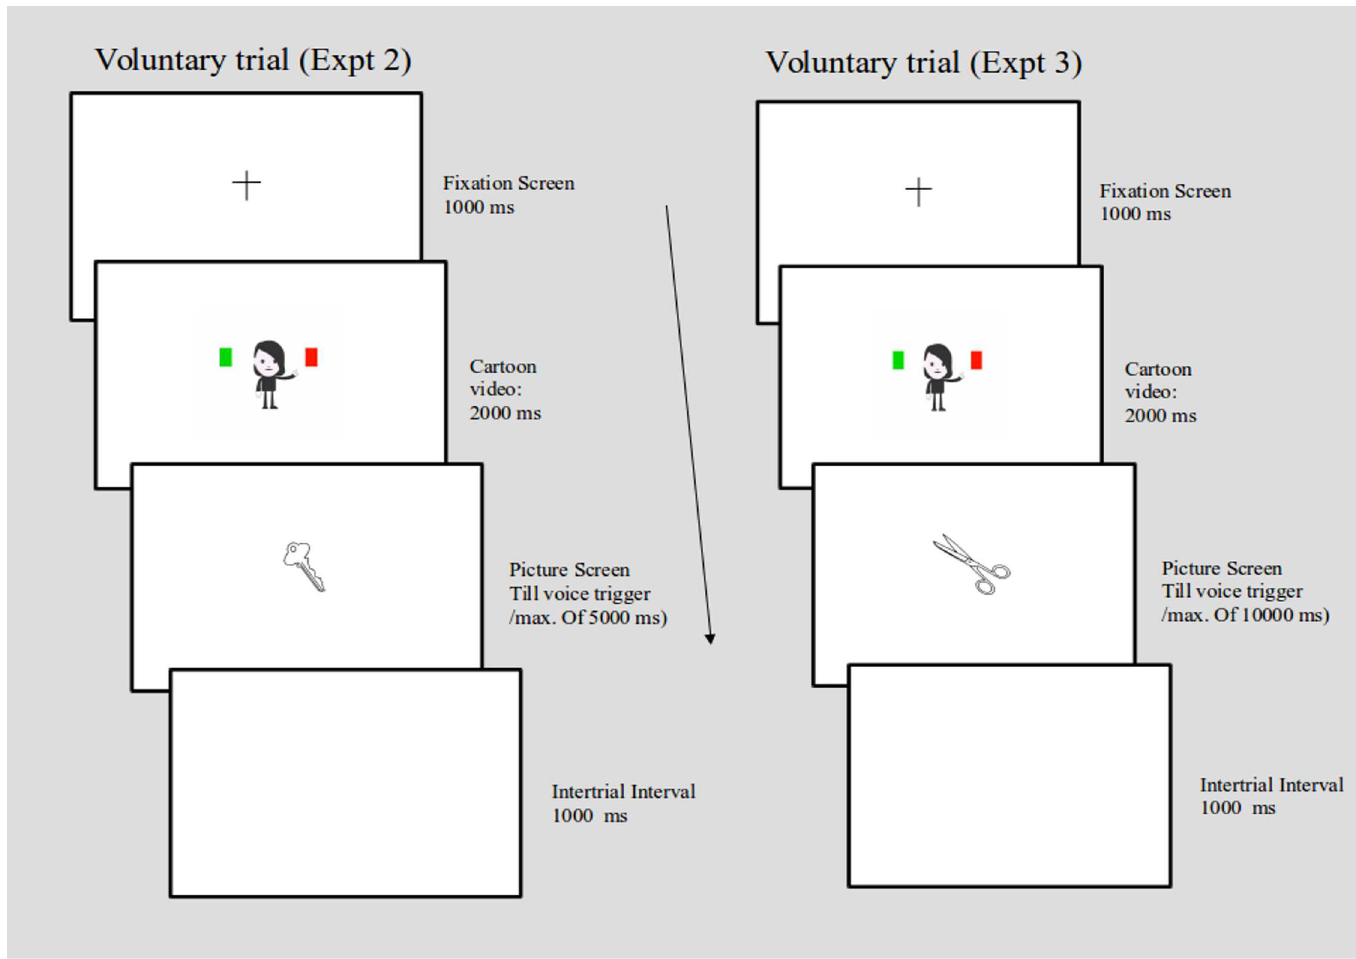
Fig 2. Sequence of events on voluntary trials in Experiment 2 and Experiment